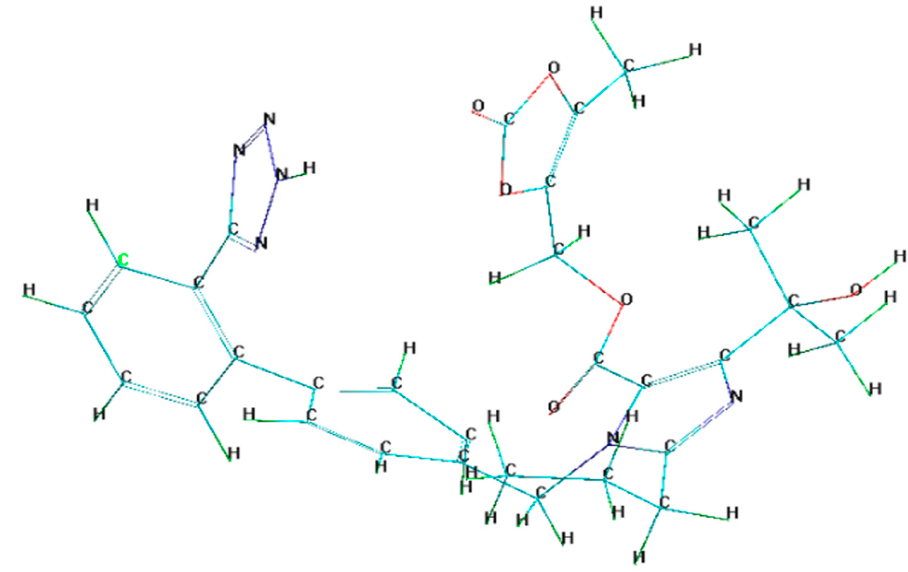
Figure 6. The optimized structure of olmesartan.